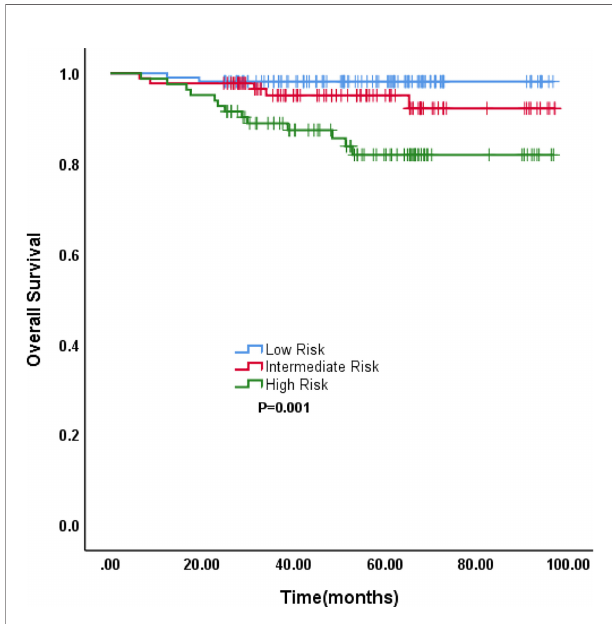
FIGURE 4 | The survival according to RPA risk strati fi